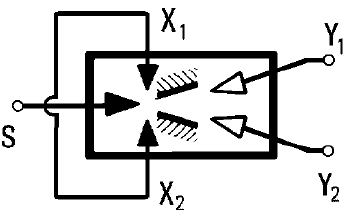
Figure 1. The Spyropoulos loop configuration for the fluidic oscillator, reproduced with permission [37]. S is the supply nozzle where gas enters, X 1 and X 2 are the control terminals where gas switches, Y 1 and Y 2 are the outlets where microporous spargers can be connected with oscillatory gas output. These spargers are placed in liquid and generate bubbles.